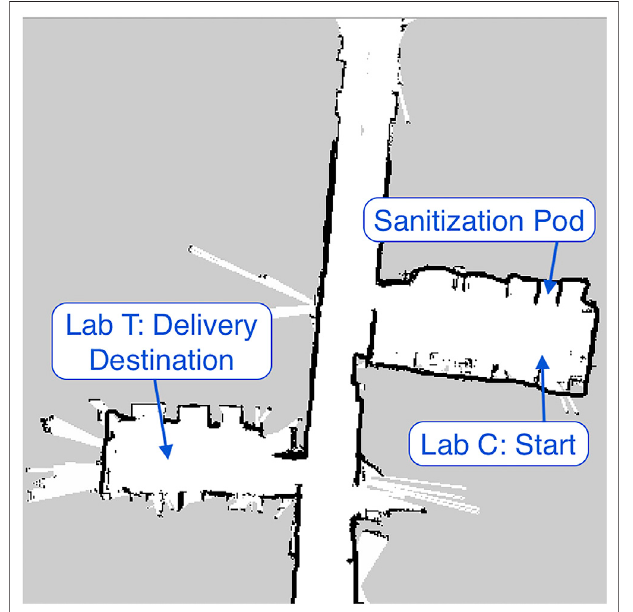
FIGURE 3 | Map generated for turtlebot navigation using the ROS gmapping package and an astra depth camera.